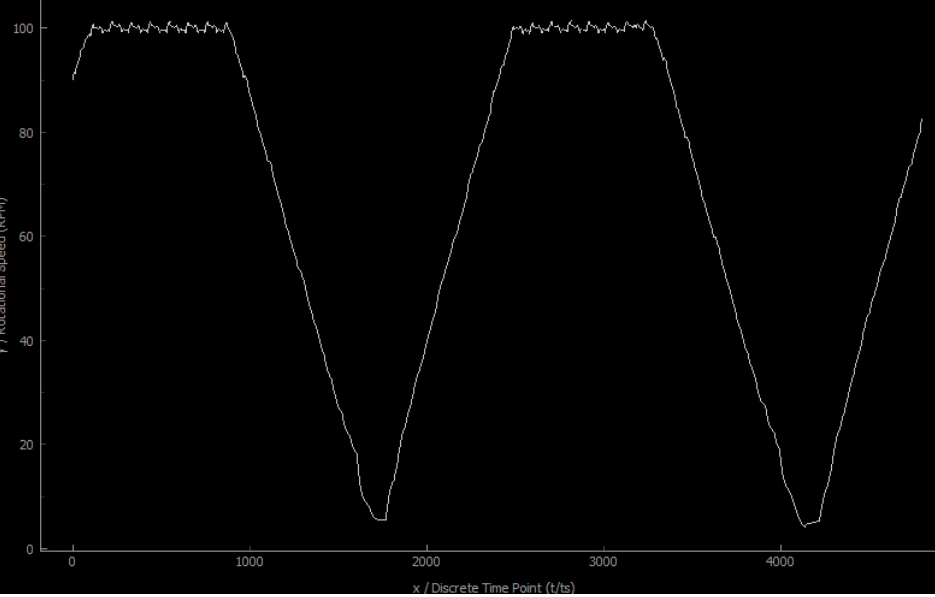
Figure 14. Speed curve of the measuring results based on the Hall effect gear tooth sensor CYGTS102DC and the signal processing unit CYSPU-98A .